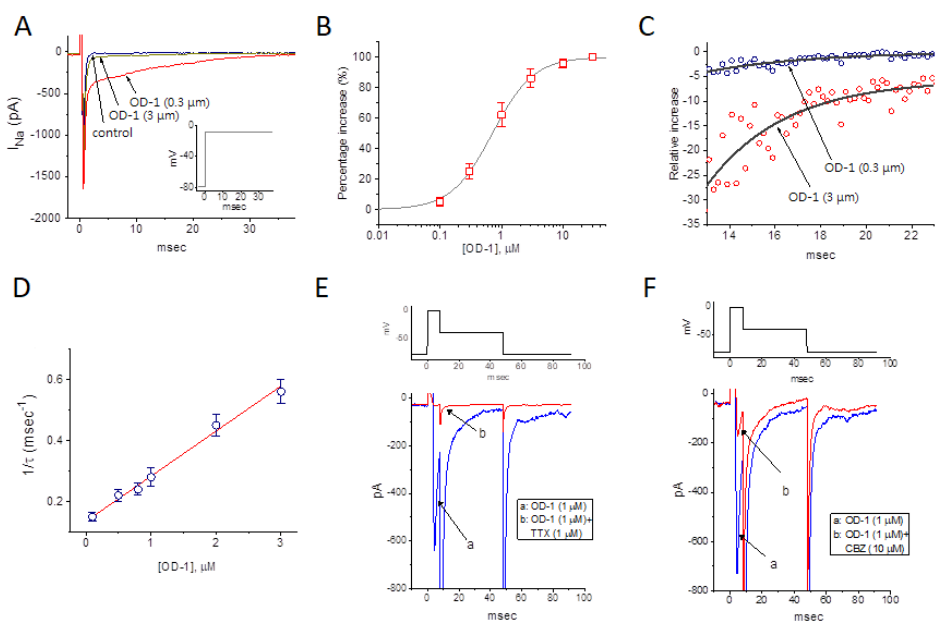
Figure 1. Stimulatory e ff ect of OD-1 on voltage-gated Na + current ( I Na ). In these experiments, cells were bathedinCa 2 + -freeTyrode’ssolution, andtherecordingpipettewasfilledwithaCs + -containingsolution. ( A ) Representative I Na traces were obtained in the control (control) and during exposure to 0.3 µ M OD-1 and 3 µ M OD-1. The inset indicates the voltage protocol used. ( B ) Concentration-dependent e ff ect of OD-1 on the peak amplitude of I Na (mean ± SEM; n = 9–11 for each point). The peak amplitude of I Na in response to brief membrane depolarization from − 80 to − 10 mV was measured. The peak I Na during exposure to 30 µ M OD-1 was taken to be 100%. The continuous line represents the best fit of the data points to the sigmoidal Hill equation, as detailed in the Materials and Methods section. The EC 50 values and Hill coe ffi cient were 0.71 µ M and 1.3, respectively. ( C ) Time courses of the relative increase in I Na following treatment with 0.3 µ M OD-1 (a) and 3 µ M OD-1 (b). The trajectory in the presence of 0.3 µ M OD-1 and 3 µ M OD-1 was fitted using a single exponential (as indicated by smooth curves) with a value of 4.62 and 3.43 msec, respectively. The relative increase (i.e., ( I control - I OD-1 ) / I control ) was evaluated by dividing the OD-1-sensitive current by the current obtained in the control. ( D ) The relationship of the reciprocal to the time constant (i.e., 1 / τ ) of the relative increase versus the OD-1 concentration was plotted (mean ± SEM; n = 9–12 for each point). The data points shown in the open circles were fitted using a linear regression and indicated that there was a molecularity of one. On the basis of the binding scheme, the forward ( k + 1 *) and backward ( k − 1 ) rate constants for OD-1-induced stimulation of I Na were calculated to be 0.148 msec − 1 µ M − 1 and 0.135 msec − 1 , respectively. ( E ) E ff ect of OD-1 and OD-1 plus tetrodotoxin (TTX) on voltage-gated Na + current in mHippoE-14 neurons. Cells were bathed in Ca 2 + -free, Tyrode’s solution, and the pipette was filled with a Cs + -containing solution. The current trace labeled “a” was obtained in the presence of 1 µ M OD-1, while that labeled “b” was obtained after further addition of 1 µ M TTX, but still in the presence of 1 µ M OD-1. The upper part shows the applied voltage-clamp protocol. ( F ) E ff ect of OD-1 and OD-1 plus carbamazepine (CBZ) on voltage-gated Na + current in mHippoE-14 neurons. Cells were bathed in Ca 2 + -free, Tyrode’s solution, and the pipette was filled with a Cs + -containing solution. The current trace labeled “a” was obtained in the presence of 1 µ M OD-1, while that labeled “b” was obtained after further addition of 10 µ M CBZ, but still in the presence of 1 µ M OD-1. The upper part shows the voltage-clamp protocol applied. Data were analyzed using a one-way ANOVA with the least-significant di ff erence post hoc